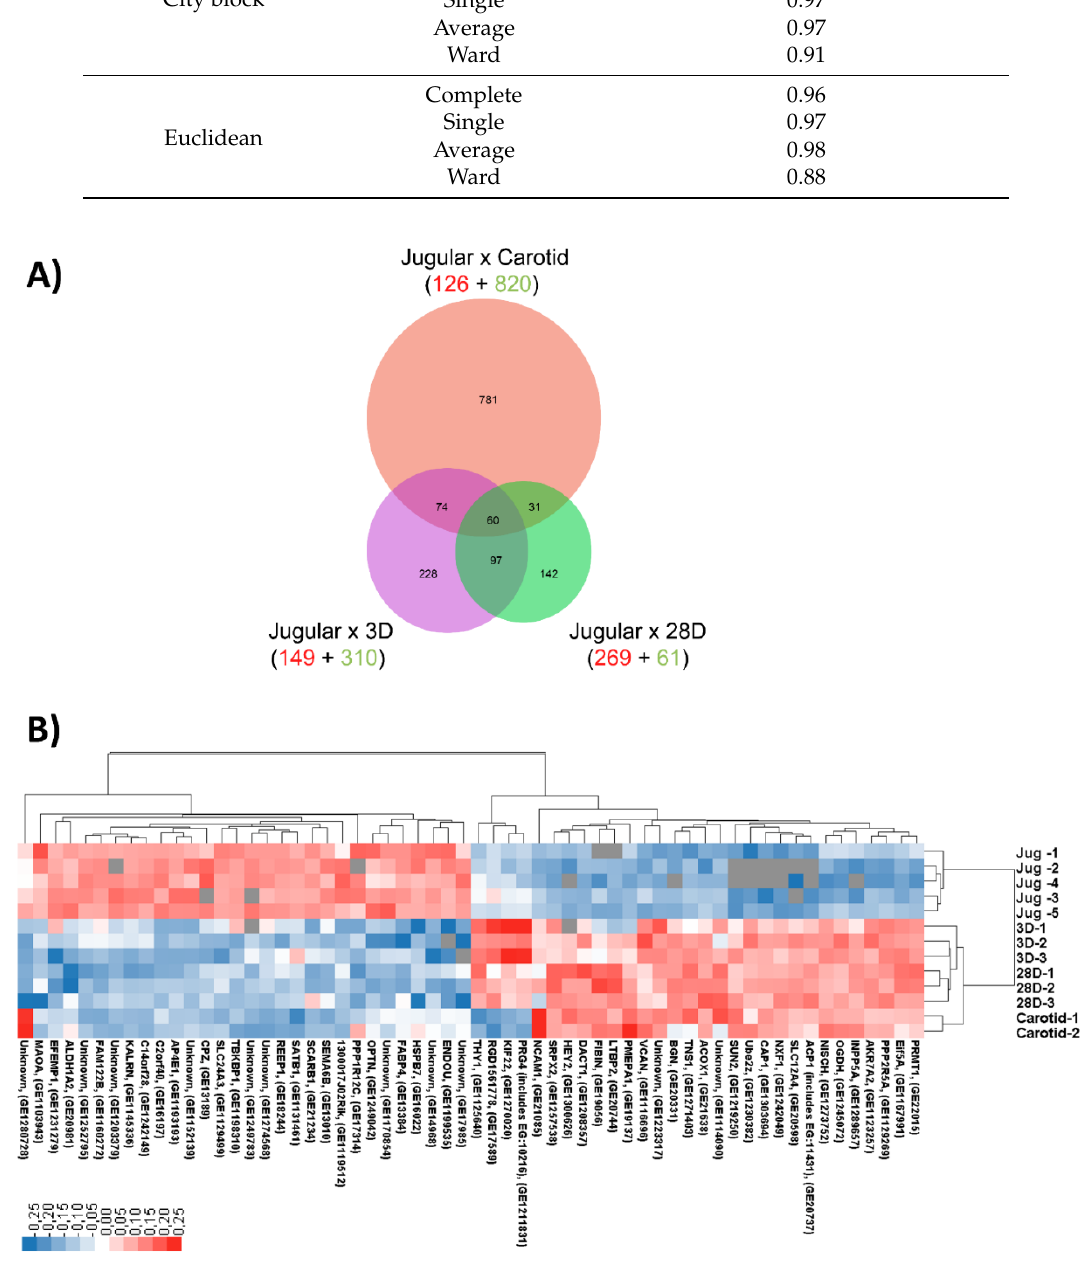
Figure 3. Genes differentially expressed between vein and artery and modulated in arterialized veins foreshadow a directional shift in gene expression for arterialized samples. ( A ) Venn diagram showing the statistically significant differentially expressed genes (1845 genes); ( B ) Hierarchical clustering of the 60 genes differentially expressed among all groups. Downregulated genes are represented in blue, and upregulated genes are represented in red.